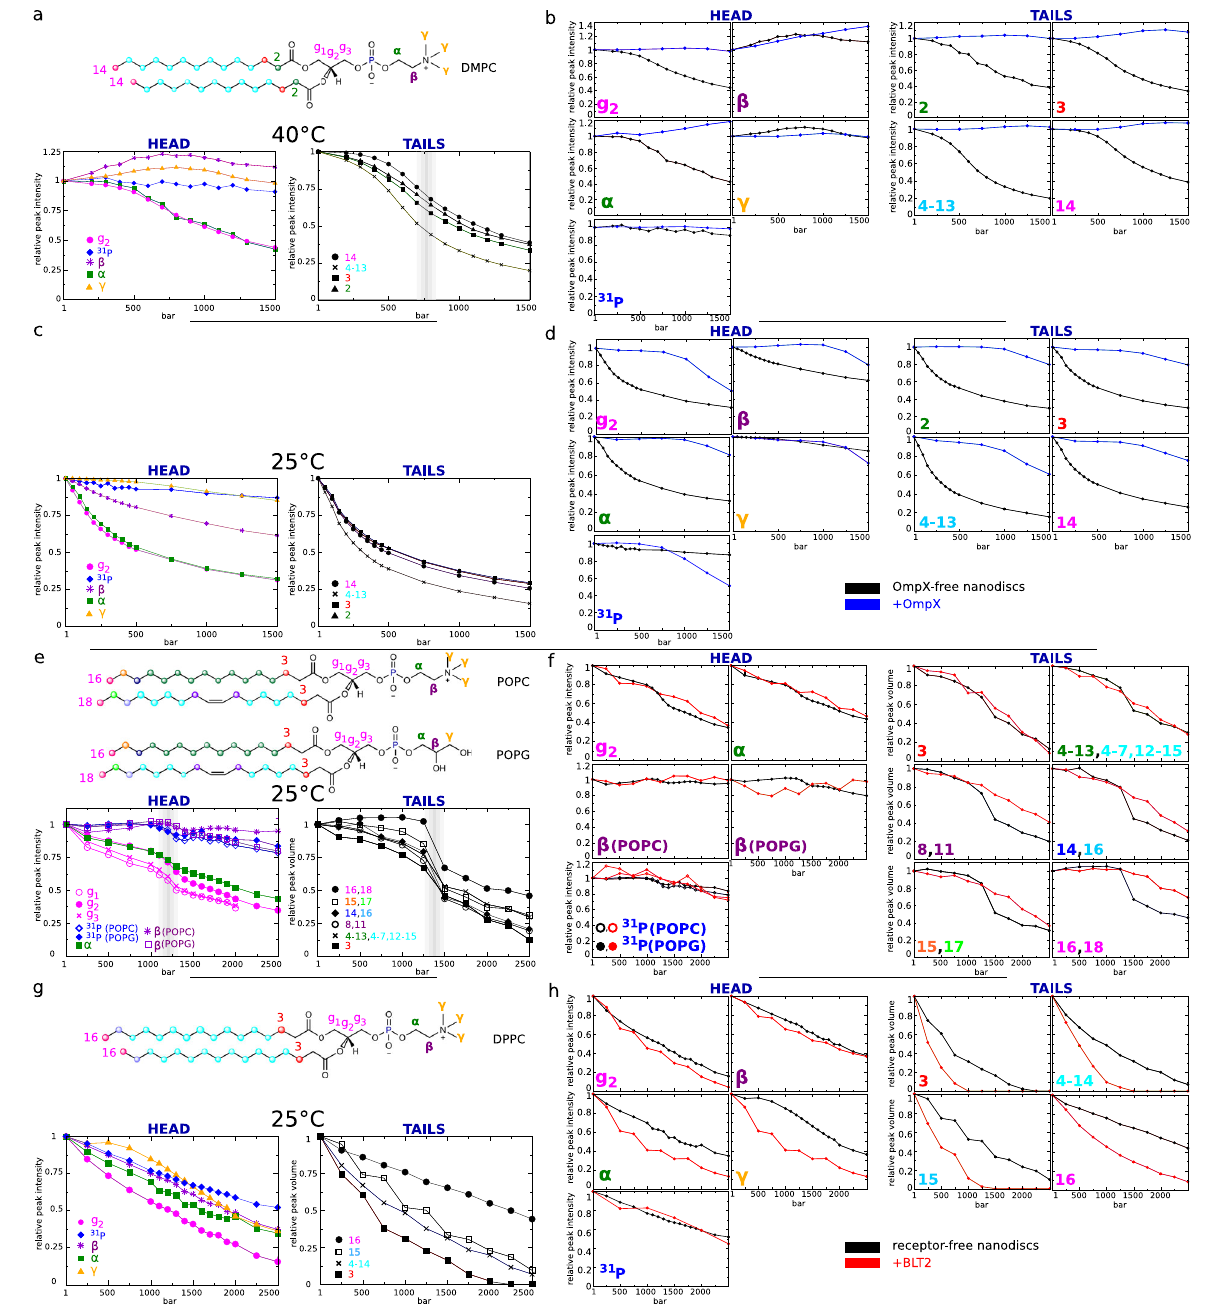
Fig. 2 Barotropic behavior of lipid NMR signals. a , c , e , and g describe the evolution of MP-free nanodisc NMR signals for, respectively, DMPC at 40°C and 25°C, POPC/POPG, and DPPC nanodiscs at 25°C. In b , d , f , and h , the evolution of MP-free nanodisc lipid NMR signals (in black) are compared with OmpX-containing (in blue) or BLT2-containing nanodiscs (in red). Head and tail protons are shown separately. The color code indicated on lipid primary structures are reproduced in the labels of the graphs. The volume or intensity of reference for each signal has been taken at atmospheric pressure. The vertical gray bands indicate pressure-induced phase transition. γ protons of POPC and POPG are not represented because their NMR chemical shifts could not be unambiguously assigned. In the presence of MPs, it was not possible to measure the evolution of 1 H NMR signals of g1 and g3 for all lipids (see also spectra in Fig. S4 and S5). Source data are provided as a Source Data fi